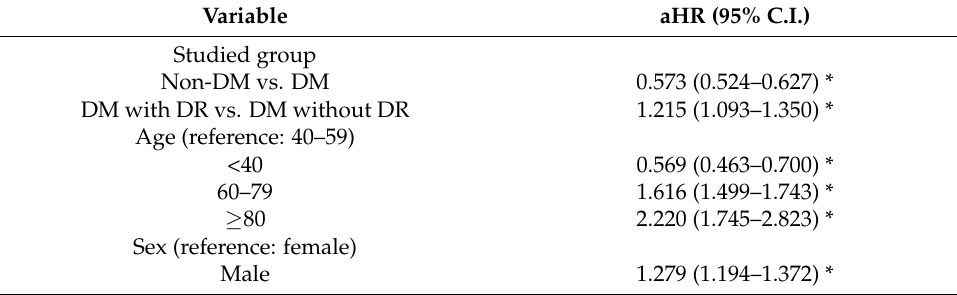
Table 4. Adjusted hazard ratios of CVD among all study